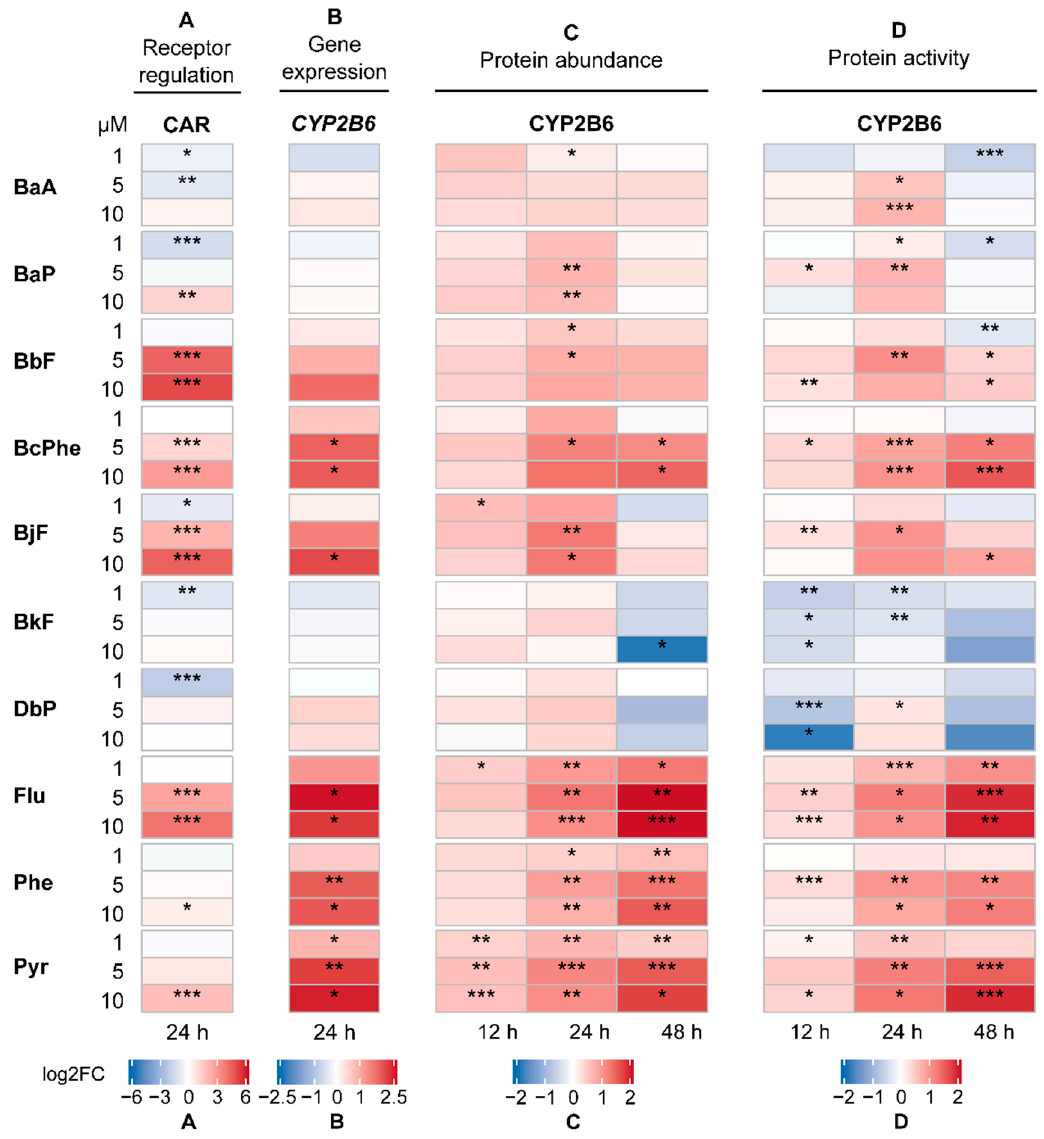
Figure 4. Cumulated heatmaps of receptor regulation ( A ), gene expression ( B ), protein abundance ( C ), and protein activity ( D ) of constitutive androstane receptor (CAR) and its target cytochrome P450 monooxygenase 2B6 (CYP2B6). Respective experiments were conducted as described in the Materials and Methods section. For protein abundance and activity, the following applied: For values below the respective lower limit of quantification (LLOQ), the value half of the LLOQ was used for calculations. Generally, mean values were calculated from the individually measured raw data. Fold changes with regard to the respective solvent control were determined and then log2-transformed (log2FC). A positive regulation is indicated by red shades, a negative regulation by blue shades. Statistical analysis was performed with Student’s t -test ( n = 3, * p ≤ 0.05, ** p ≤ 0.01, *** p ≤ 0.001). Underlying fold changes and standard deviations can be found in in the Supple- mentary Materials “Underlying Data”.